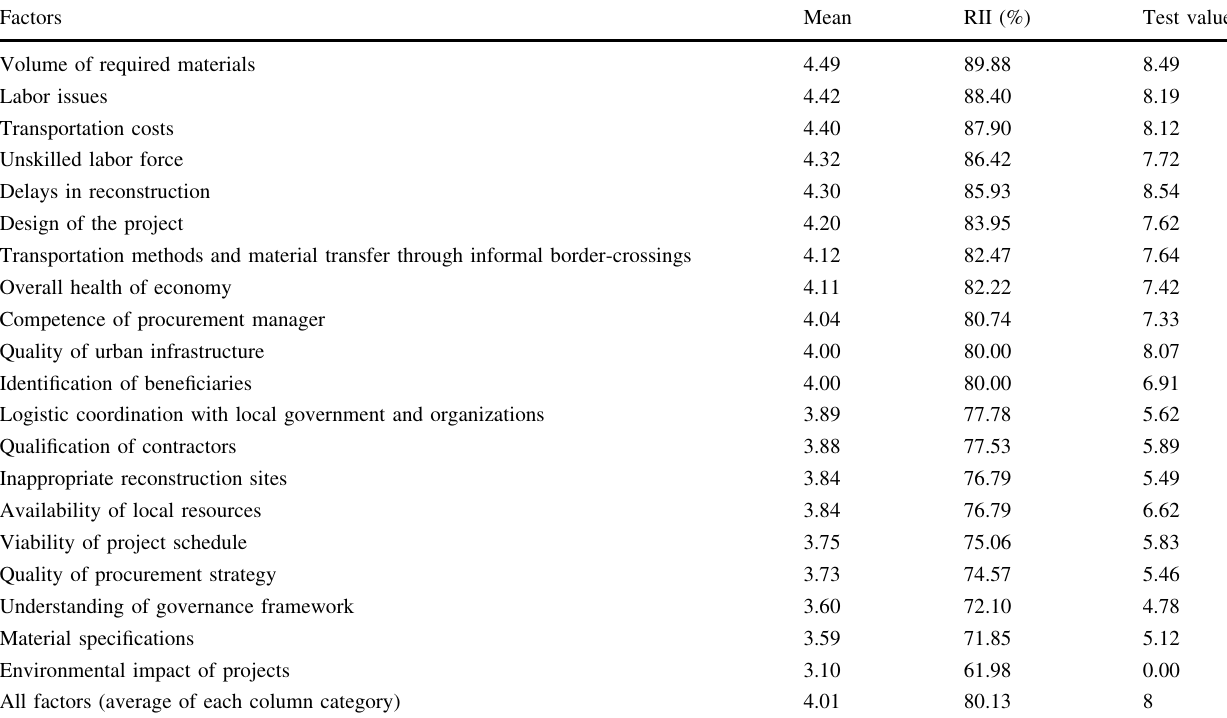
Table 5 Factors influencing supply chain and logistics in the Gaza Strip